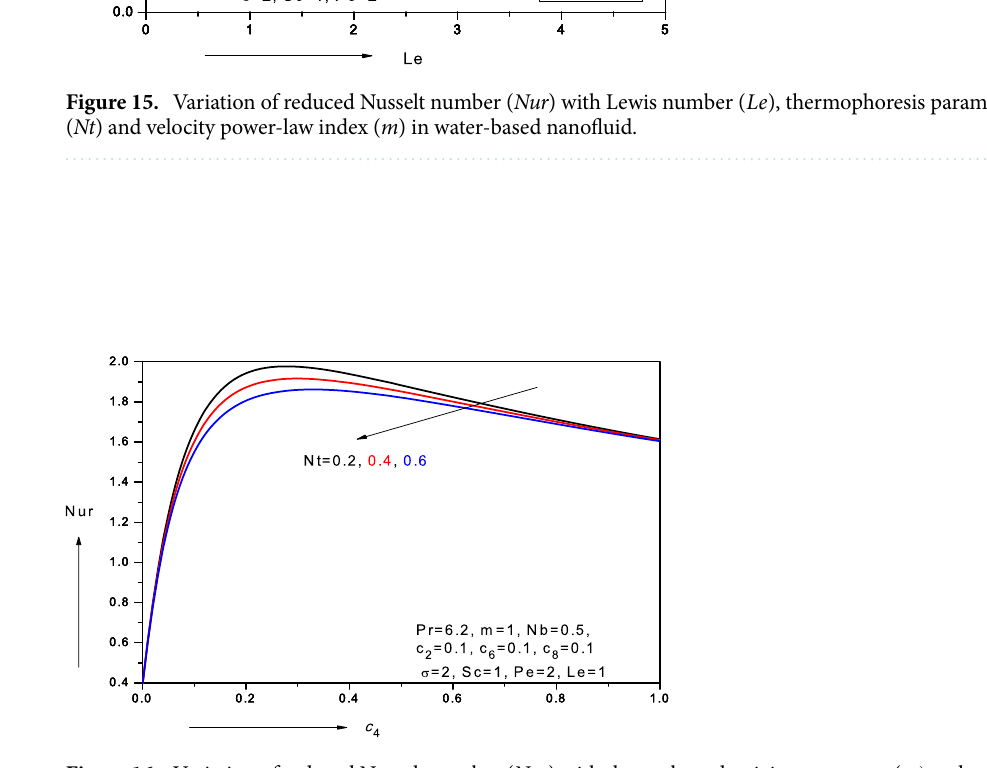
Figure 16. Variation of reduced Nusselt number ( Nur ) with thermal conductivity parameter ( c 4 ) and thermophoresis parameter ( Nt ) in water-based